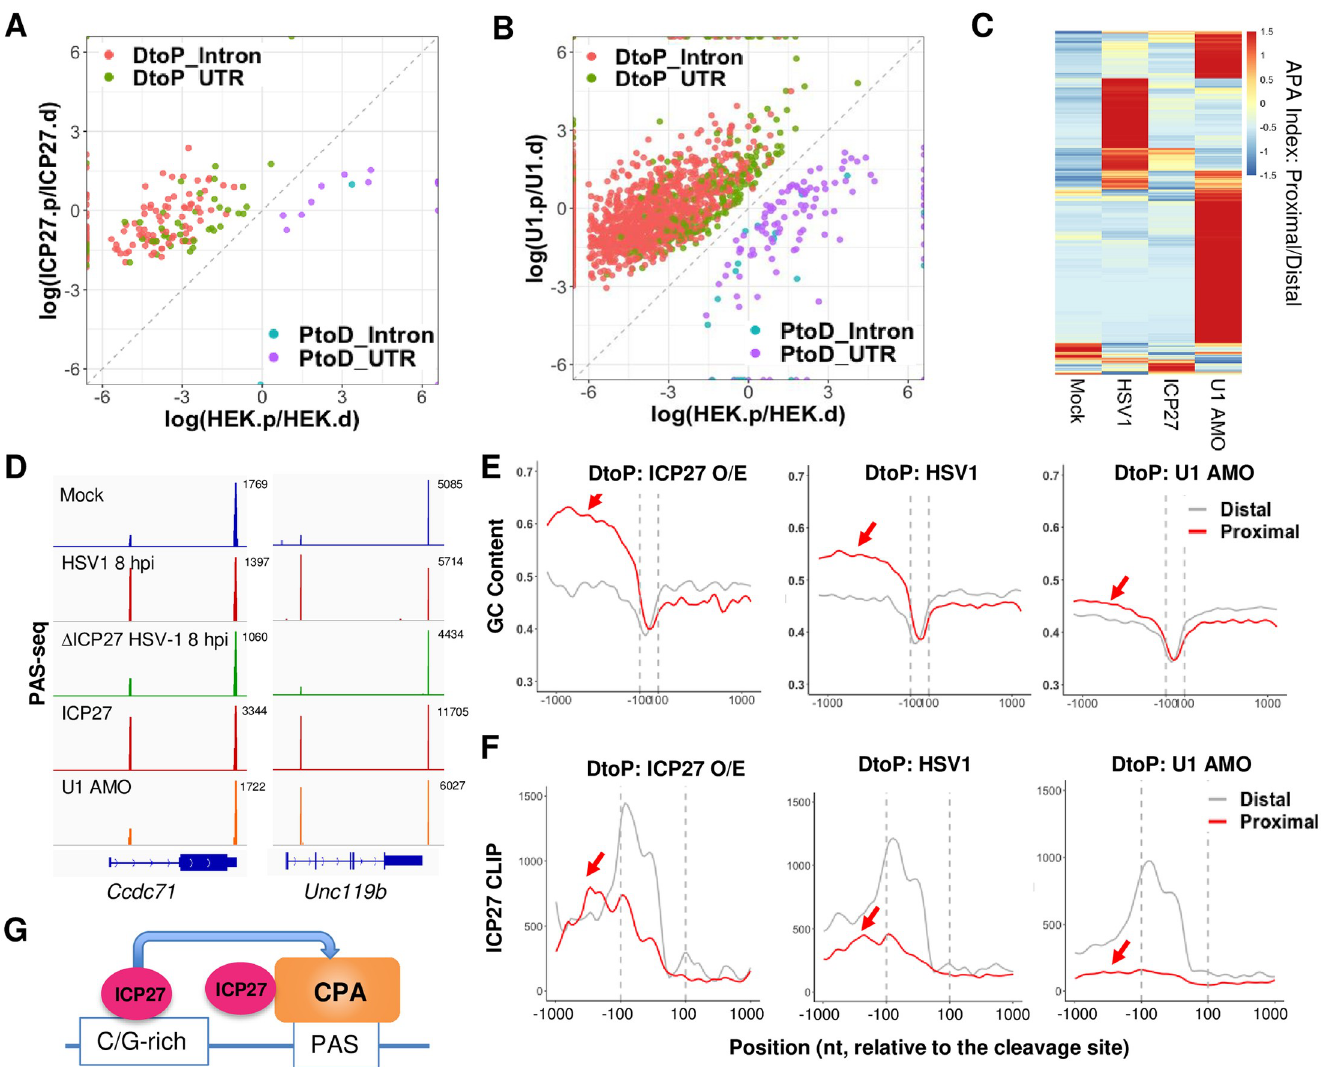
Fig 4. Mechanism of HSV-1-mediated APA regulation. (A) A scatter plot showing the significant APA changes induced by ICP27 over-expression in HEK293 cells. Color scheme and labeling are similar to Fig 1A. (B) A scatter plot showing the significant APA changes induced by U1 antisense morpholino oligo (AMO)-treatment of HEK293 cells. (C) A heat map of APA index of all genes that displayed significant APA changes induced by HSV-1-infection, ICP27 over-expression, or U1 AMO. Data was scaled by row. (D) PAS-seq tracks for two example genes. (E) GC content at the proximal and distal PAS of genes that displayed significant DtoP shifts induced by ICP27 over-expression (O/E), HSV-1 infection (HSV1), or U1 AMO treatment. (F) ICP27 CLIP signals at the proximal and distal PAS of genes that displayed significant DtoP shifts induced by ICP27 over-expression (O/E), HSV-1 infection (HSV1), or U1 AMO